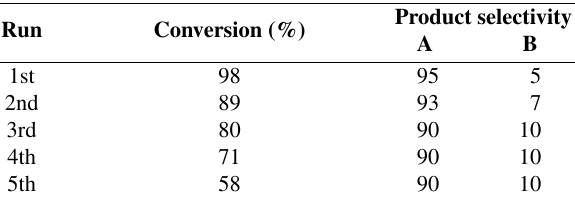
Table 5. Recyclability of L-prol-N-pMCM-41 for aminolysis of styrene oxide with